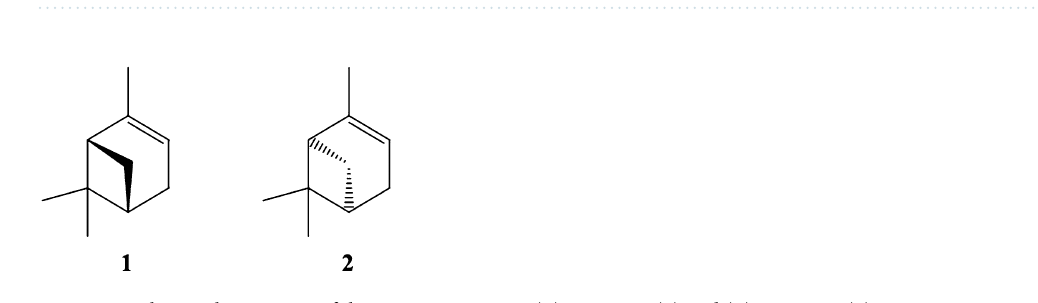
Table 1. Taxonomic classification of commercial essential oils of P. sylvestris by the developed PLS-DA model 4 and the enantiomeric excess of (−)-α-pinene. Data were expressed as mean ± standard deviation ( n = 3).